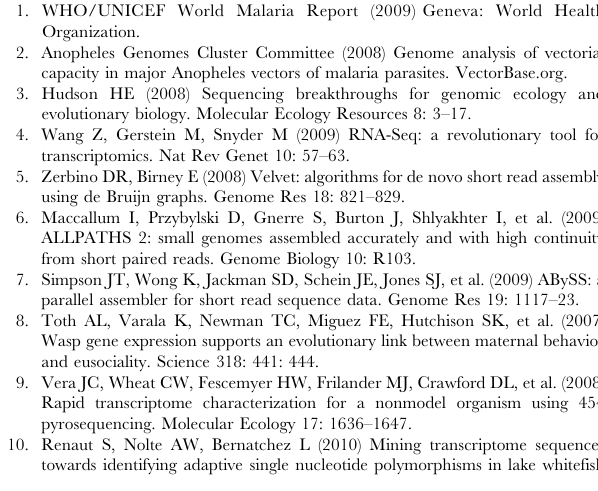
Table S2 Putative An. funestus immune genes. Excel spread- sheet containing significant BLAST matches between An. funestus contigs and An. gambiae immune genes from ImmunoDB. BLAST e-values as well as relevant immunity annotations are presented.